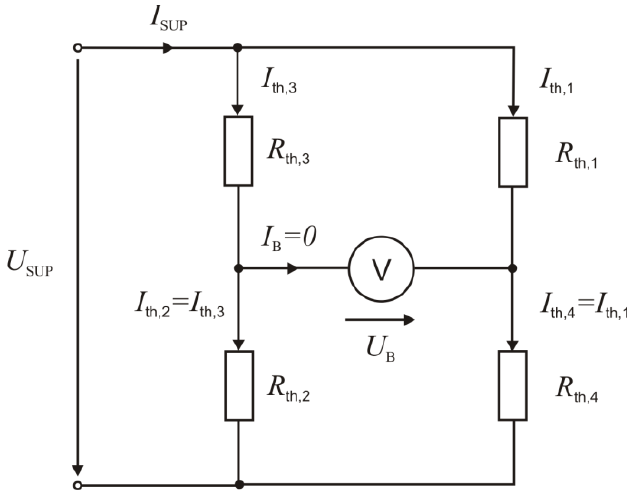
Figure 4. Wheatstone bridge featuring four membrane thermistors. The bridge is supplied by a constant current I